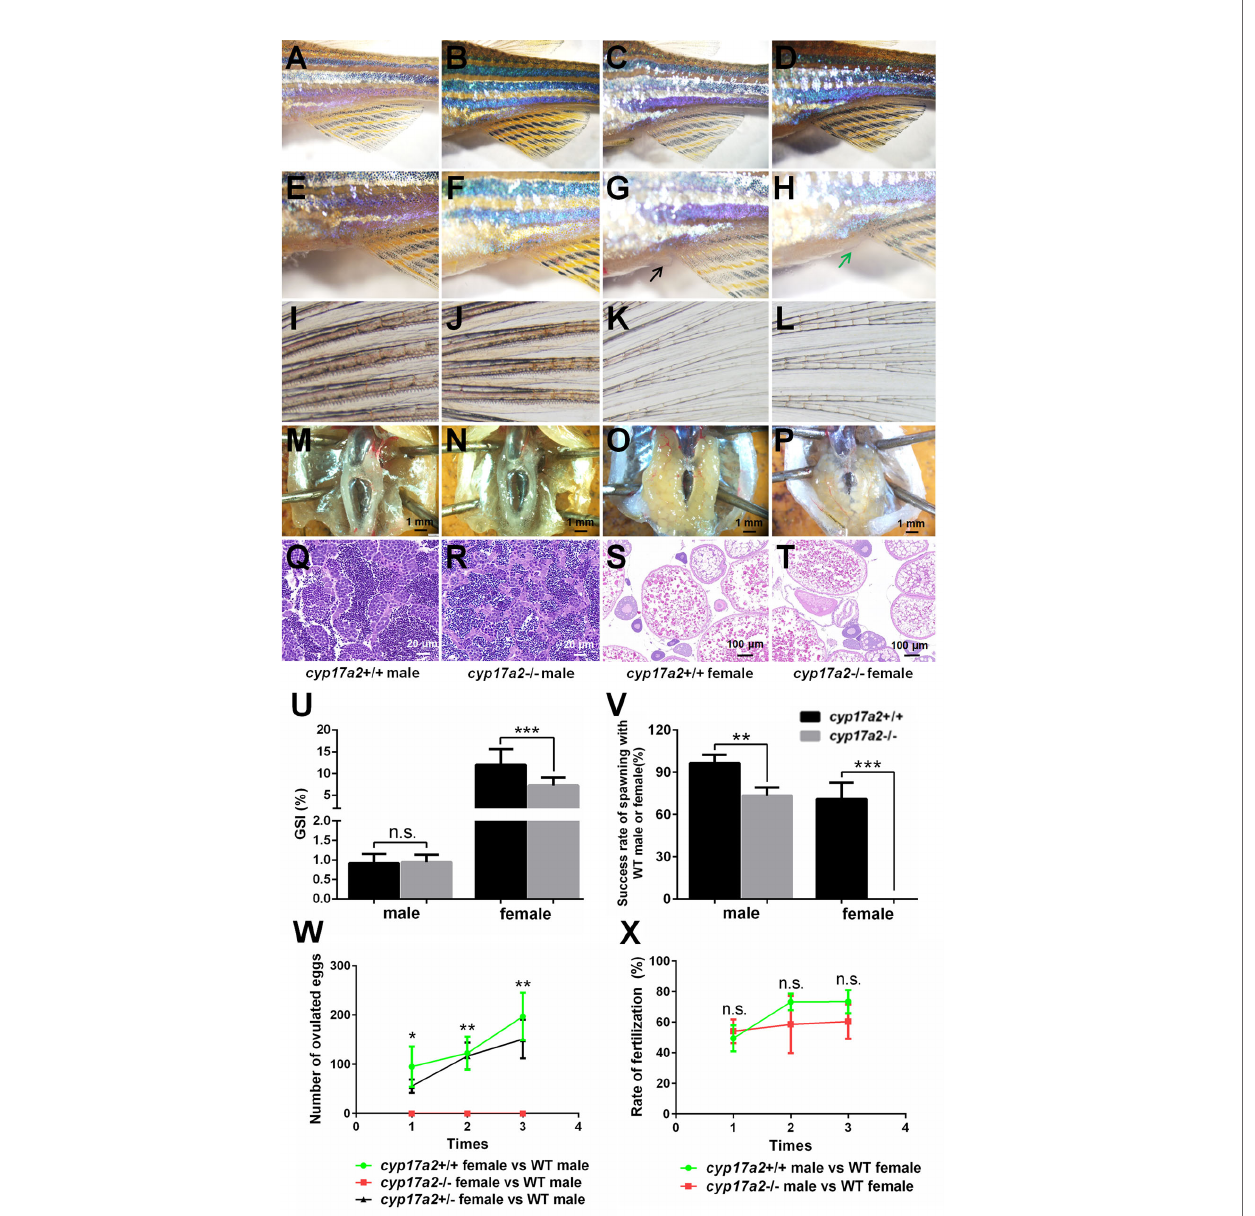
FIGURE 5 | The analyses of primary and secondary sex characters and fertility assessment. (A – D) Gross appearance of cyp17a2 +/+ male, cyp17a2 -/- male, cyp17a2 +/+ female, cyp17a2 -/- female (n = 10). (E – H) The genital papilla. (I – L) The pectoral fi n. (M – P) The anatomical observations. (Q – T) The histological analysis of gonads. Black and green arrow indicates normal and diminished genital papilla, respectively. (U) GSI of cyp17a2 +/+ fi sh and cyp17a2 -/- fi sh at 3 mpf (n > 10). (V) The fertility analysis of cyp17a2 -/- males and cyp17a2 -/- females mated with WT females and males, respectively (n = 10). (W) The statistical analyses of ovulated eggs of cyp17a2 +/+, cyp17a2 +/- and cyp17a2 -/- females mated with WT males (n = 10). (X) The statistical analyses of fertilization ratio of the ovulated eggs from WT females when mated with cyp17a2 +/+ males and cyp17a2 -/- males, respectively (n = 10). n.s., no signi fi cant difference. * P < 0.05. ** P < 0.01. *** P <